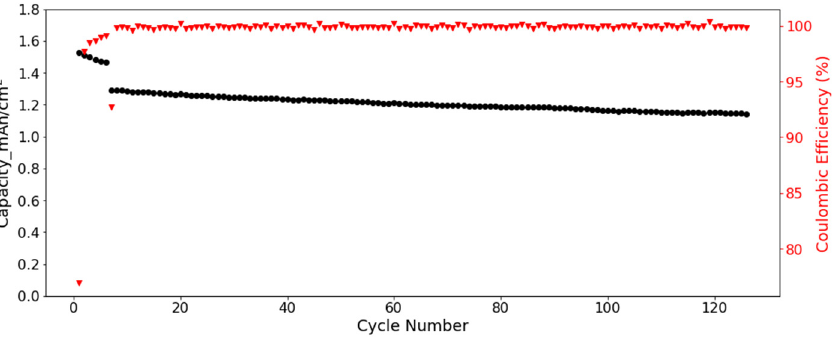
Figure 8. Cycling performance and columbic efficiency of the SF hard carbon electrode with NCM 523 as cathode under a current of 1/3 C in coin cell. 523 as cathode under a current of 1/3 C in coin